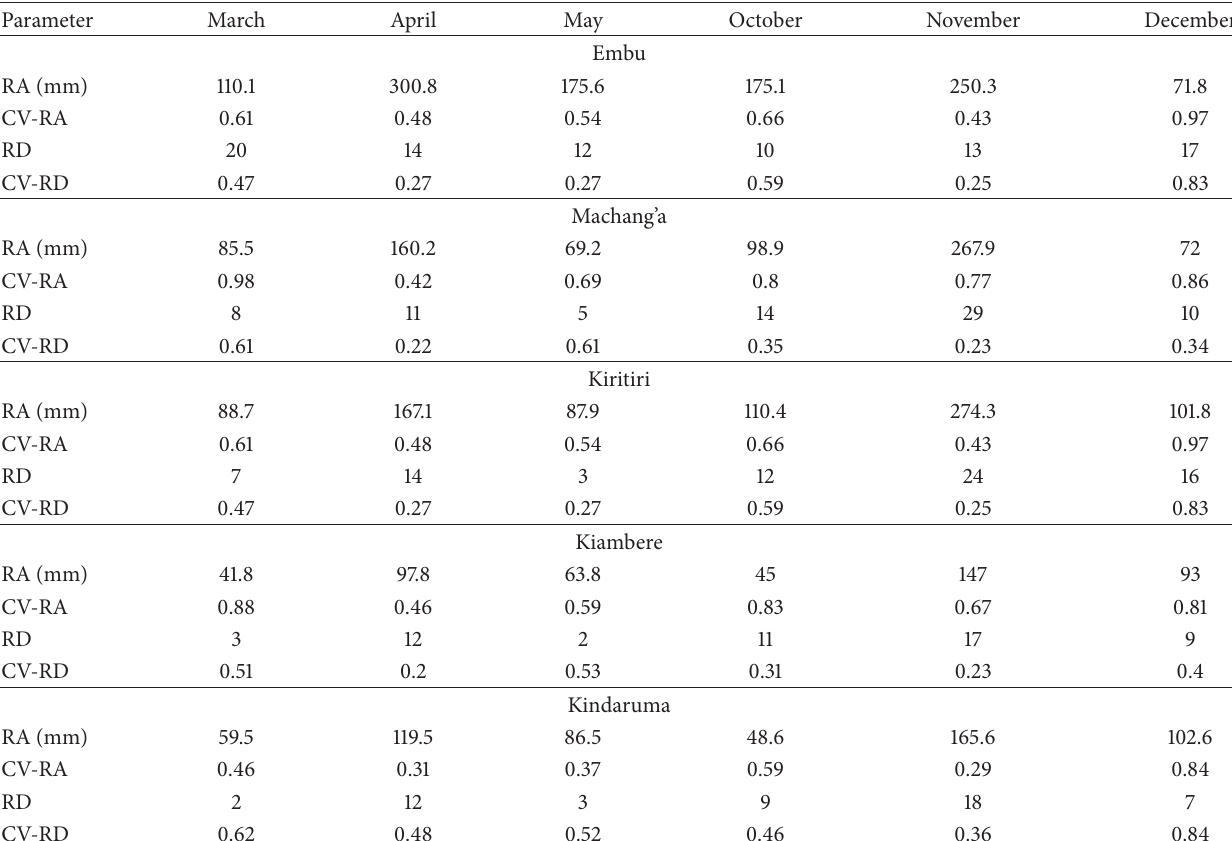
Table 6: Variability in rainfall amounts and number of rainy days during seasonal months for studied stations for the period between 2000 and